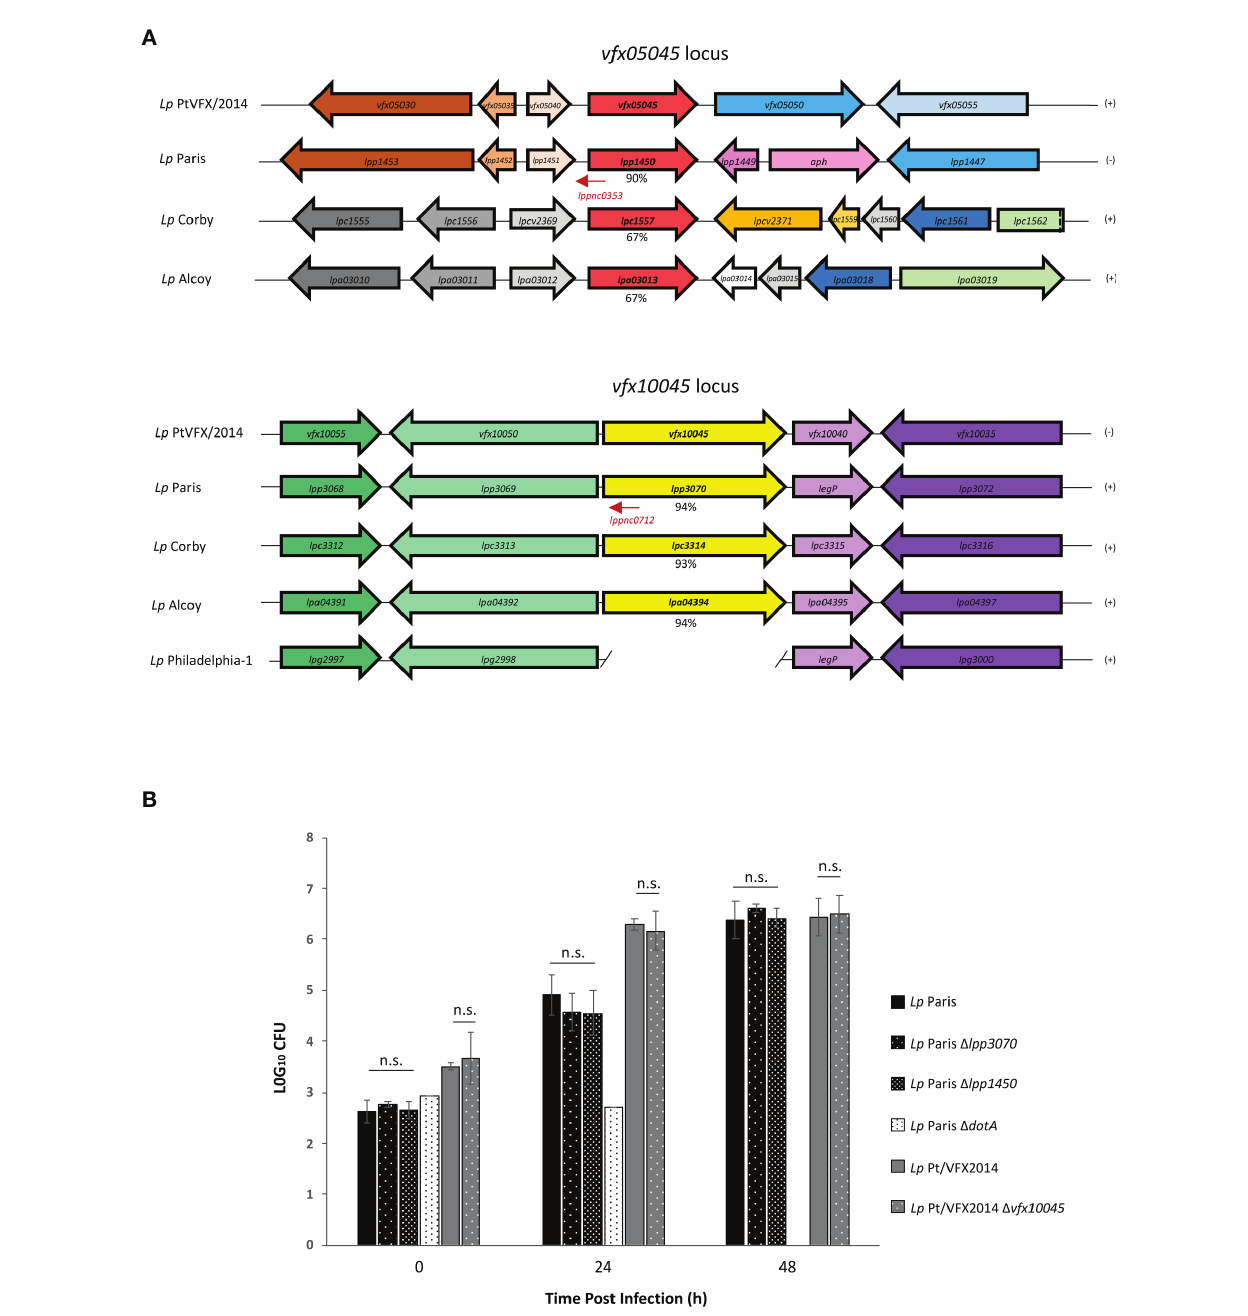
FIGURE 2 | Effector encoding genes vfx10045/lpp3070 and vfx05045/lpp1450 are present in the genomes of other L. pneumophila strains and dispensable for intracellular replication in THP-1 macrophages. (A) Genetic organization of the vfx05045 and vfx10045 loci in L. pneumophila outbreak strain and of homologs in L. pneumophila Paris, Corby, Alcoy and Philadelphia-1. Identical colors re fl ect amino acid identity >60% at the encoded protein level. lppnc represent non-coding RNAs (LegioList database). The percentages of identity at the amino acid level of proteins VFX05045 and VFX10045 with homologs are indicated. (B) Intracellular replication asssays of L. pneumophila Paris and derivatives D dotA, D lpp1450 and D lpp3070 , and L. pneumophila Pt/VFX2014 and derivative D vfx10045 were performed by infecting THP-1 macrophages for 90 minutes with a multiplicity of infection of 0.1. To kill extracellular bacteria, cells were then incubated with RPMI containing gentamicin 100 µg/ml for 1 hour, after which cells were washed with PBS and fresh RPMI was added (T 0 ). At 0, 24 and 48 h post-infection lysis was accomplished in 1 ml of sterile water at room temperature for 15 min. The lysate was subjected to appropriate serial dilutions, plated on CYE and CFUs counted. The results shown represent the average and standard deviation of 3 independent experiments, each assayed in duplicate. n.s., non-signi fi cant statistical differences relative corresponding parental